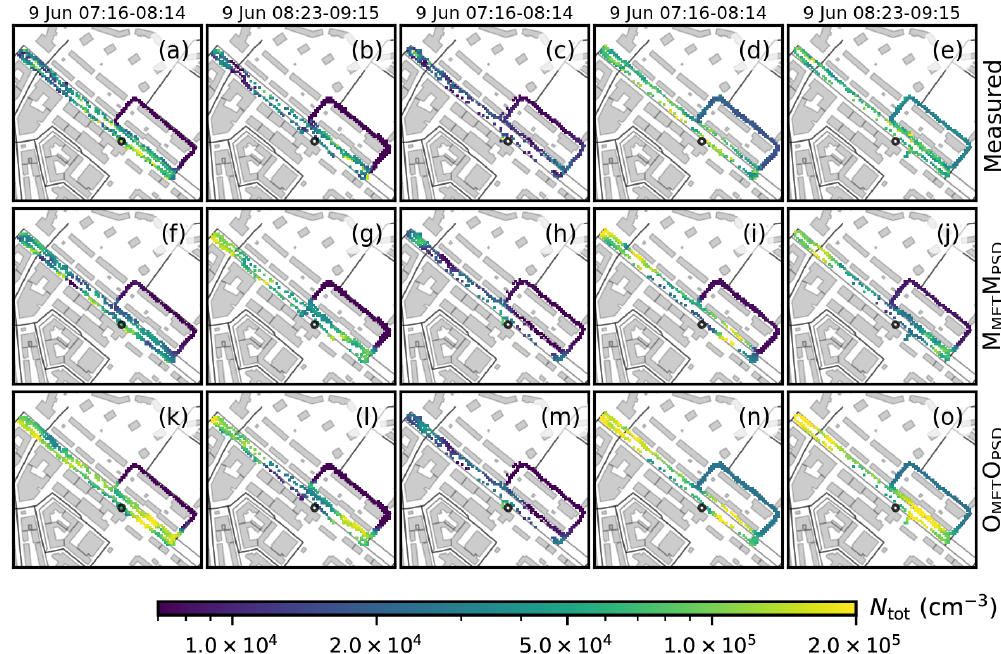
Figure 3. Measured (a–e) and modelled (f–o) median total aerosol number concentration ( N tot ) along the Sniffer route for the summer morning ( a, f, k for the first and b, g, l for the second hour), summer evening (c, h, m) and winter morning ( d, i, n for the first and e, j, o for the second hour). The second row shows M MET M PSD and the third O MET O PSD . Measurements are from z = 2 . 4m and modelled values from z = 2 . 5m. The supersite is marked with a black